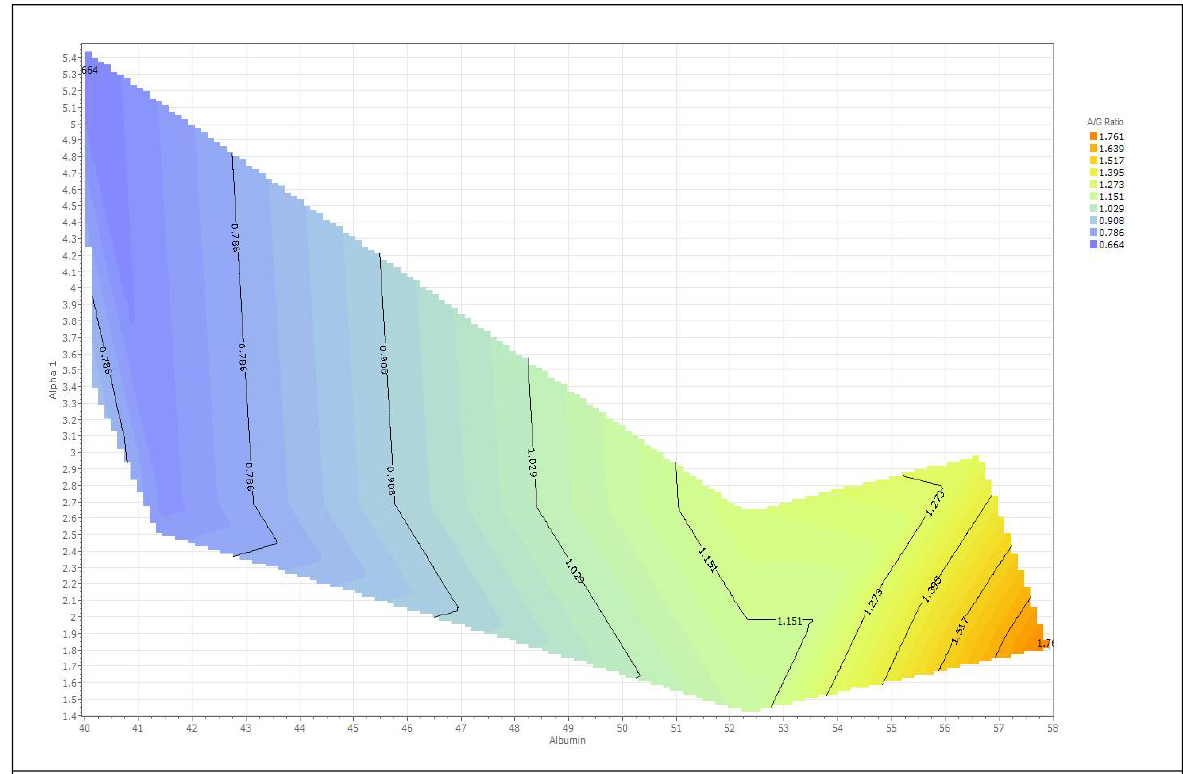
The contour maps of the regression model are depicted from Figures 10 to